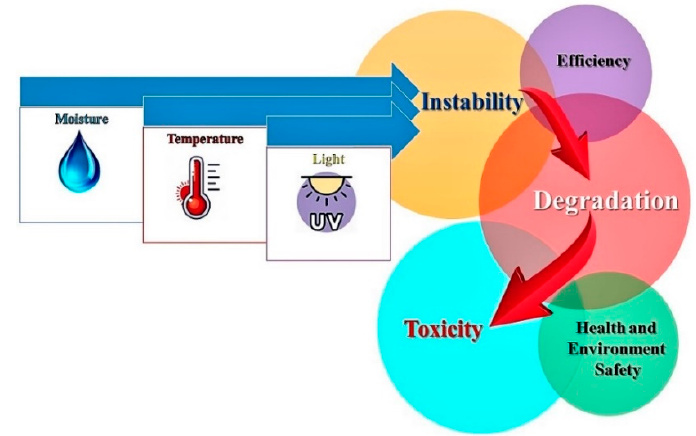
Figure 4. Major challenges of PSCs according to instability and toxicity.